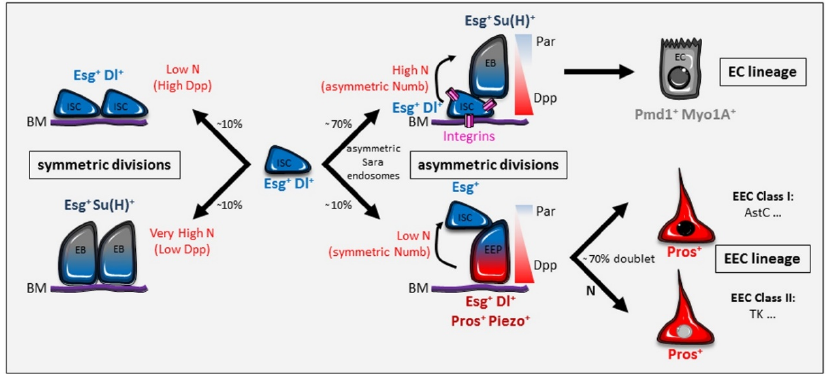
Figure 2. Division modes of Drosophila ISC. The interplay between Notch and Dpp / BMP signaling pathways, as well as the Par complex, integrins, Numb, and Sara endosomes, regulates the different daughter cell fates of ISC divisions: ISC-enteroblast, ISC-enteroendocrine precursor, ISC-ISC, and enteroblast-enteroblast. Symmetric division of the ISC can also give rise to two enteroendocrine precursors, but the signaling events have not been described (and therefore are not included in the figure). The localization of the Par complex in the apical daughter cell is necessary for the ISC asymmetric division. Two lineages, that of enterocytes and that of enteroendocrine cells, are produced depending on the level of Notch activity, which is itself regulated by Dpp / BMP, Numb, and Sara endosomes. In addition, in the enteroendocrine lineage, the Par complex regulates the correct localization of Pros in the basally located enteroendocrine precursor. Integrins allow the asymmetric localization of the Par complex during ISC-enteroblast asymmetric division, but their specific role in the enteroendocrine lineage is not known. Two main classes of enteroendocrine cells, expressing Allatostatin C (AstC) for class I and Tachykinin (Tk) for class II, are produced from the enteroendocrine precursors. Around 70% of the enteroendocrine cells form a doublet coming from the direct division of the enteroendocrine precursors. During the symmetric division, low Notch signaling (due to high Dpp / BMP) leads to ISC-ISC production. Conversely, a high Notch (low Dpp / BMP) leads to enteroblast-enteroblast production. Percentages are related to the homeostatic condition. Each cell type of the midgut can be distinguished by specific markers. See the main text for details. BM: basement membrane; ISC: intestinal stem cell; EB: enteroblast; EEP: enteroendocrine precursor; EC: enterocyte; EEC: enteroendocrine cell; N: